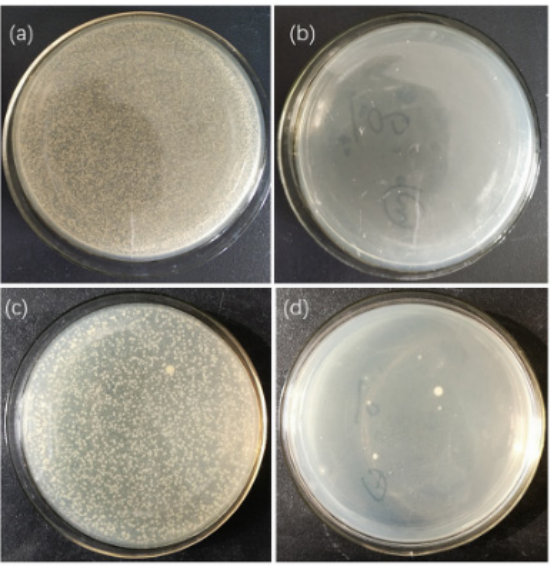
Figure 7. S. aureus colonies of ( a ) amino-treated ( b ) TiO 2 NP S -coated cotton fabric and E. coli colonies of ( c ) amino-treated ( d ) TiO 2 NP S -coated cotton fabric.